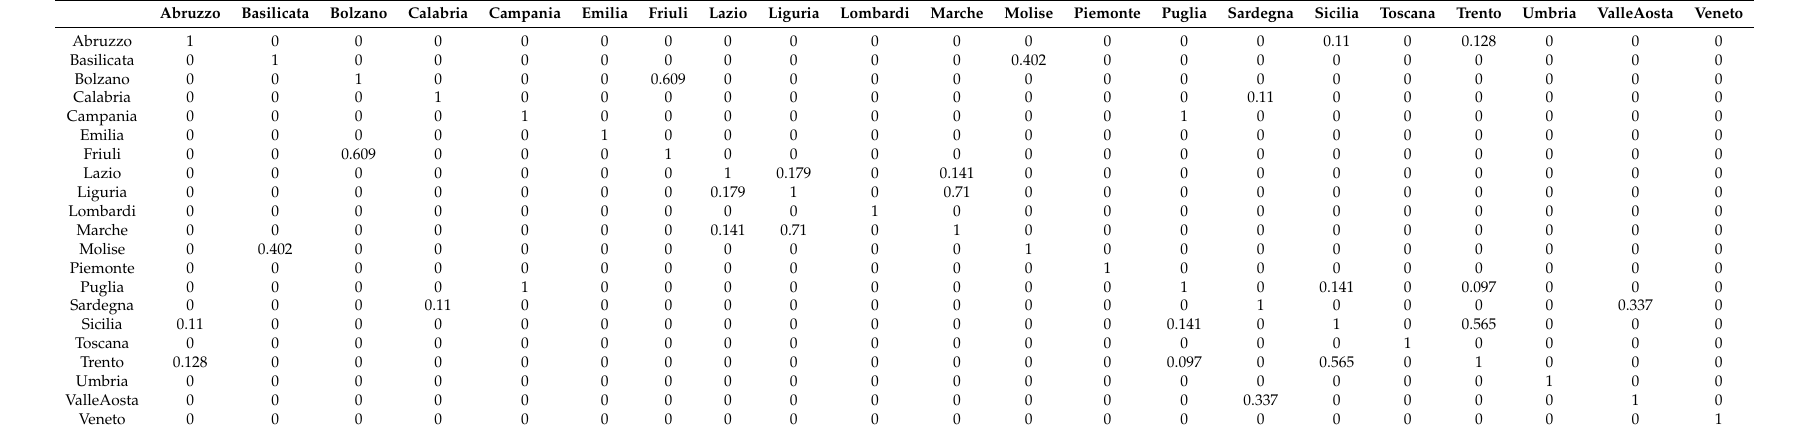
Table A18. Similarity values of Total Hospitalized network in the fifth